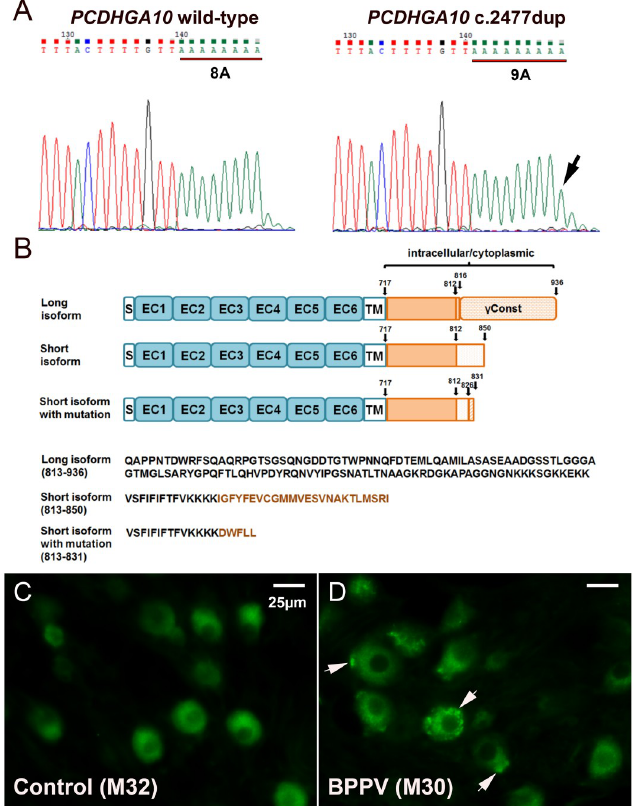
Fig 3. Frameshift variant causes premature stop, truncating the PCDHGA10 short isoform. A, Verification of the NM_032090.1:c.2476_2477dup in PCDHGA10 by Sanger sequencing after BpmI restriction digestion. B, Protein structures of PCDHGA10 long, short and mutant isoforms. EC, extracellular; TM, transmembrane; Const: Constant domain. C, Fluorescent immunostaining shows that wildtype PCDHGA10 has no large aggregates in the cytosol of non-BPPV samples at young ages (the vestibular ganglia is shown). D, PCDHGA10 with the rs113784532 mutation forms large intracellular aggregates in BPPV samples even at young ages. Arrows indicate aggregates. M30 and M32, male at 30 and 32 years of age, respectively. Scale bar, 25 μ